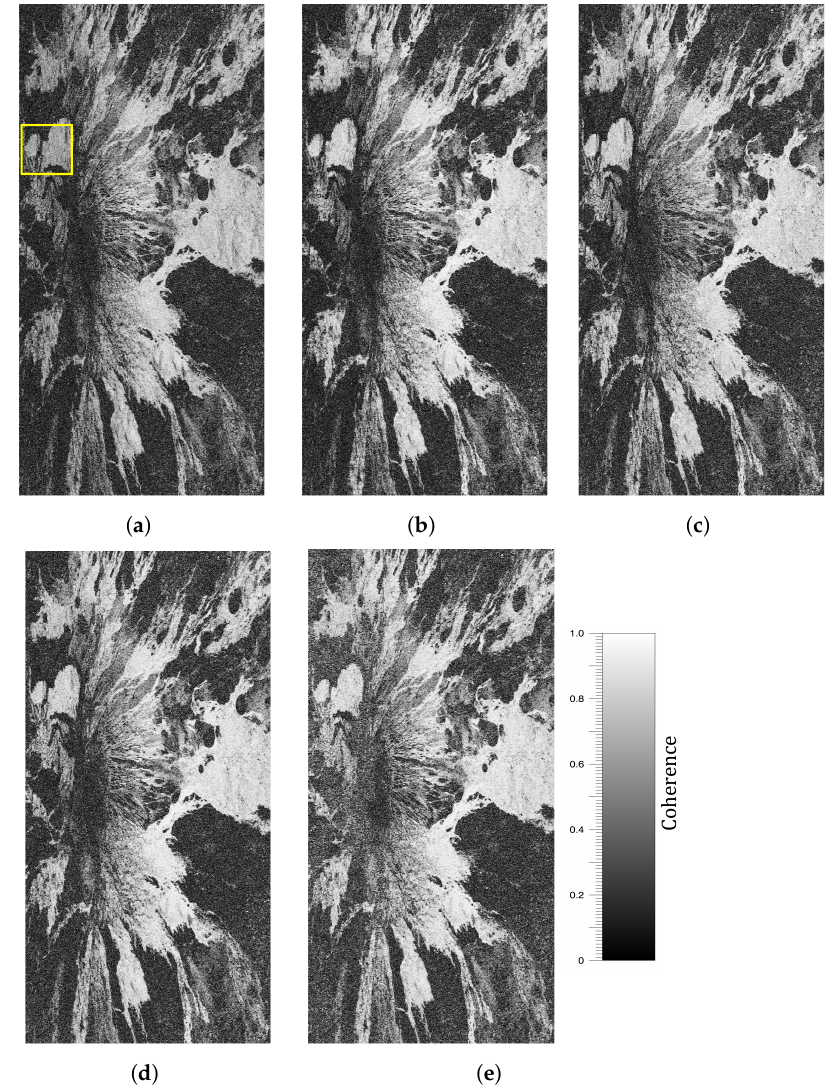
Figure 16. Coherence maps of the processed area after range filtering. ( a ) Original. ( b ) Adaptive method. ( c ) Method based on constant slope. ( d ) Slope-adaptive. ( e )Multi − scale slope-adaptive. The yellow box denotes the specific region of interest analyzed in Figures 17 and